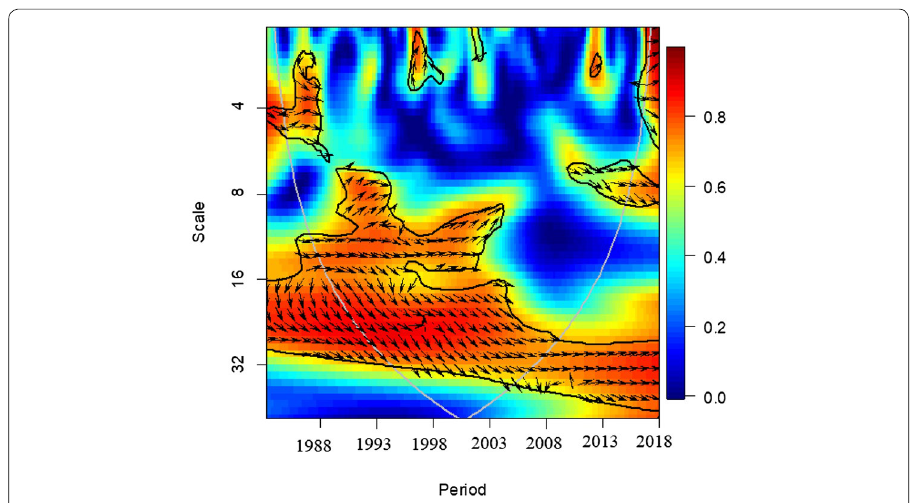
Fig. 6 Wavelet coherence between PRI and